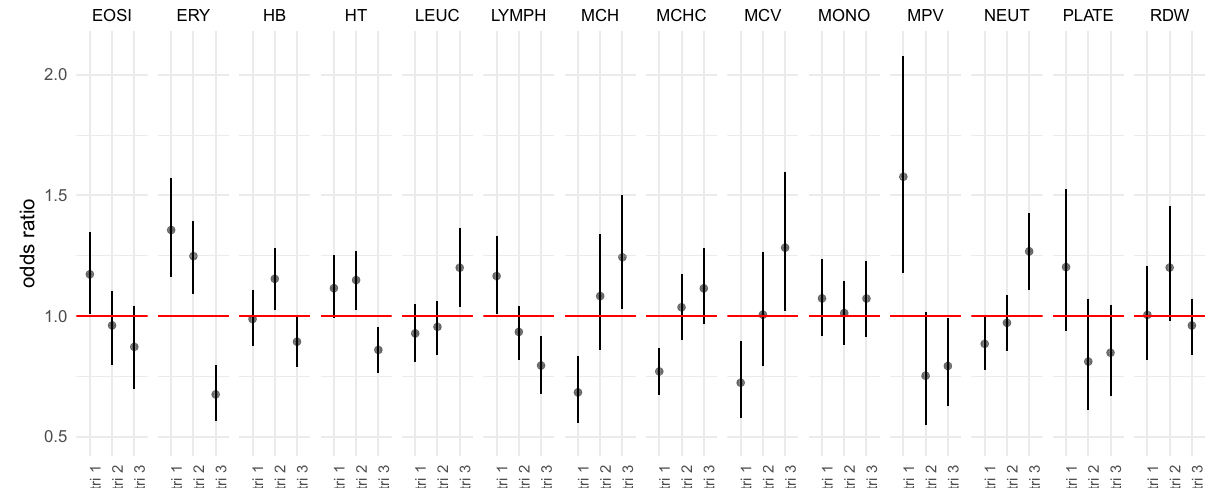
Figure 2. Trimester-specific associations of CBC values and PPH outcome. Odds ratios for complete blood count measures (CBC) recorded at each of the three trimesters (tri 1, tri 2, tri 3) for an indicator variable of whether the women lost ≥ 500 ml of blood post-partum (PPH). Values are the posterior mean, with error bars showing the 95% credible intervals, obtained from a Bayesian path coefficient model that jointly estimates relationships among blood count measures and their relationships to a binary (0/1) outcome variable. Results are shown for blood counts where the 95% credible intervals were different to odds ratio 1 for at least one trimester measure. Blood count measure abbreviations: erythrocytes (ERY, red blood cells), hematocrit levels (volume percentage of red blood cells, HT), mean corpuscular hemoglobin (MCH) and mean corpuscular hemoglobin concentration (MCHC), mean corpuscular volume (MCV), red cell distribution width (RDW), platelets (PLATE), mean platelet volume (MPV), leucocytes (LEUC), eosinophils (EOSI), lymphocytes (LYMPH), monocytes (MONO), and neutrophils outcome - blood measure associations obtained are thus specific to the changes that occur during pregnancy, with trimester 1 associations reflecting the baseline association of the values women present at the start of their pregnancy; trimester 2 associations reflecting the association of trimester 2 values adjusting for the values of each women at trimester 1; and trimester 3 associations reflecting the association of trimester 3 values adjusting for the values of each women at trimester 1 and 2.